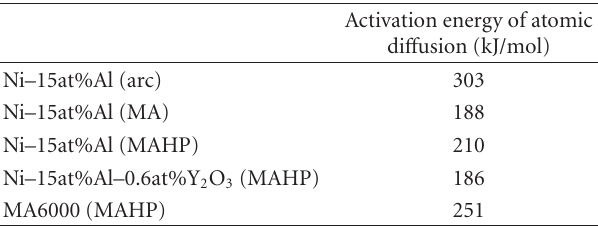
di ff usion to produce γ (cid:2) precipitates is adequately